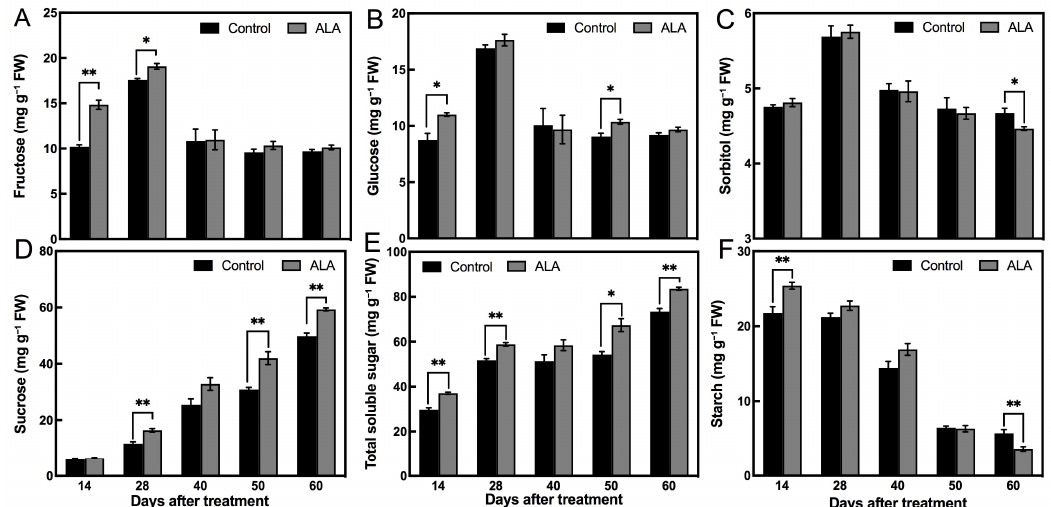
Figure 4. Effect of ALA treatment on the sugar content during nectarine development. ( A ) Fructose content. ( B ) Glucose content. ( C ) Sorbitol content. ( D ) Sucrose content. ( E ) Total soluble sugar content. ( F ) Starch content. The data are the means ± SE from three biological replicates. Bars with * indicate the di ff erences signi fi cant according to t -test. (* p < 0.05, ** p < 0.01).